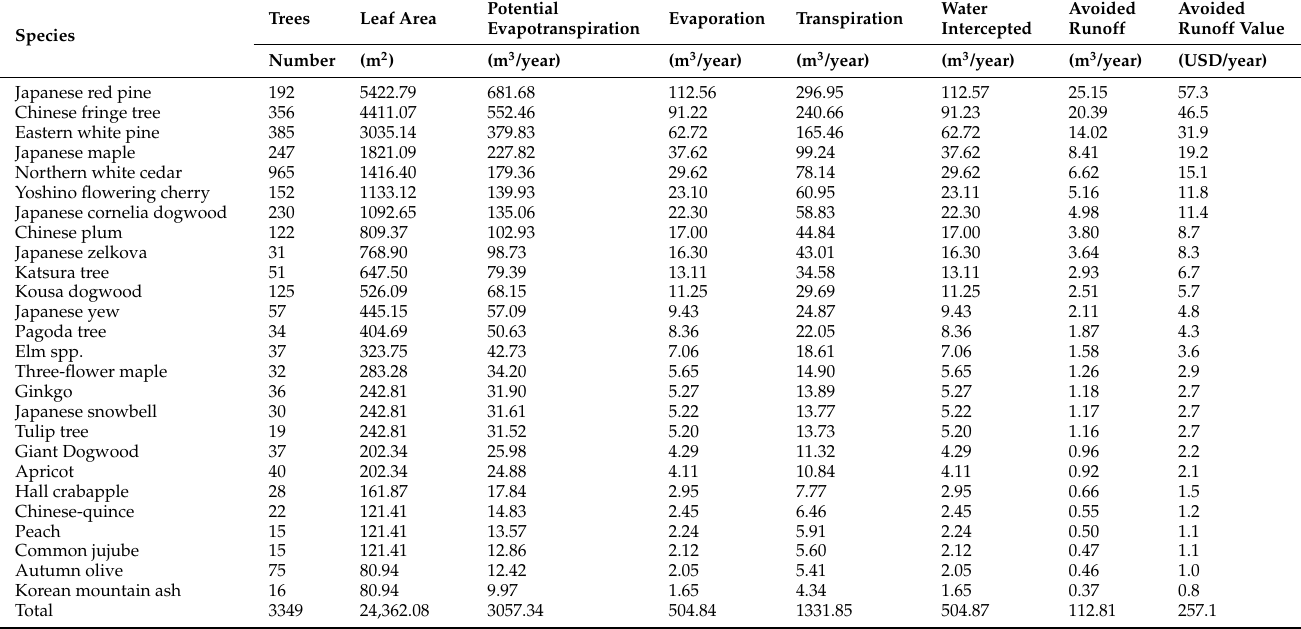
Table 5. Hydrological effects of trees by